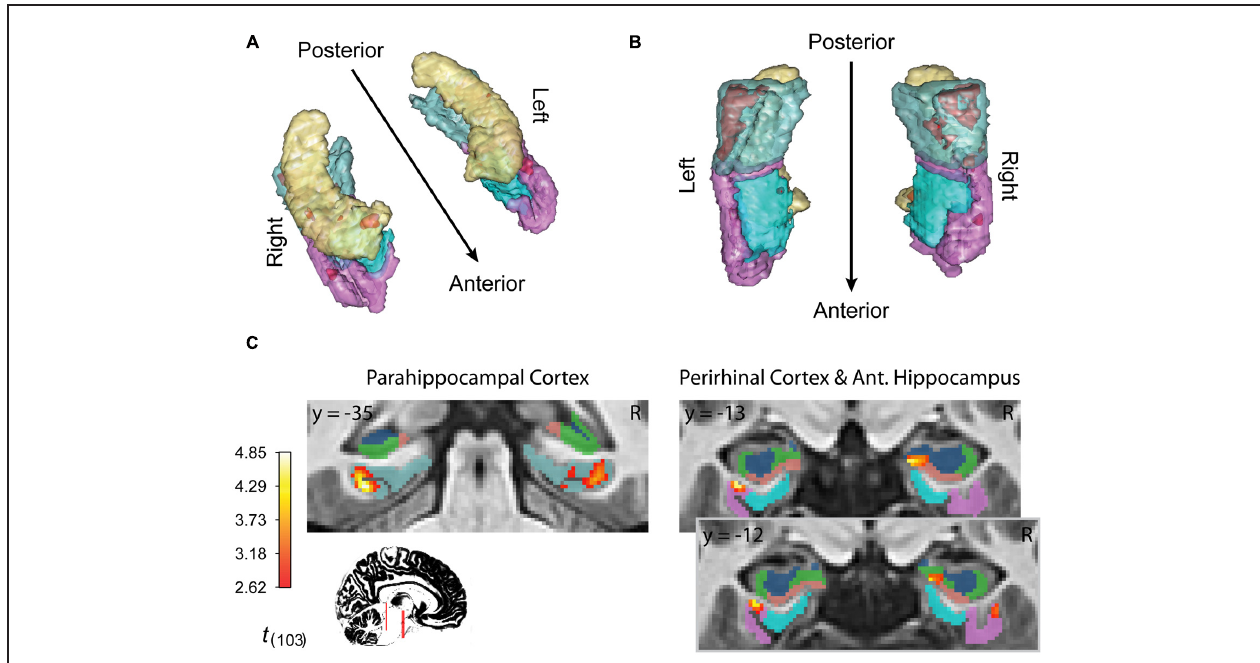
FIGURE 4 | fMRI results for ongoing encoding with slow decay. Main results from slow decay model analysis showing regions where BOLD response is initiated at the onset of the sample stimulus (see Figure 1 ) and persists into the delay period, slowly decaying with time (see Figure 3 ). The magnitude of this activity was linearly related to subsequent strength of episodic memory.